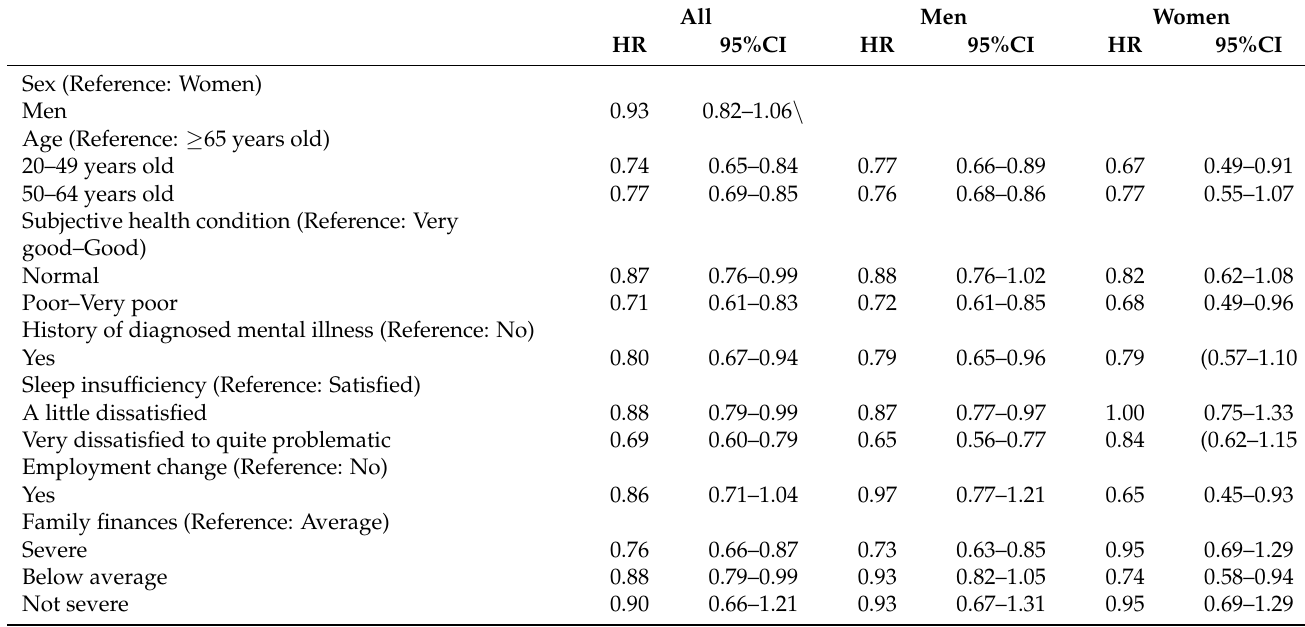
Table A5. Crude hazard ratios and 95% confidence intervals for problem drinking recovery from FY 2012 to FY 2017 excluded in FY